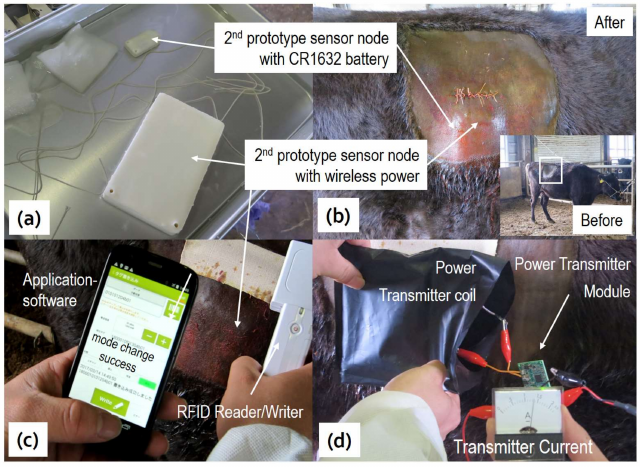
Figure 6. Photos of the sensor nodes ready for implant ( a ); the cow after implant ( b ); remote control test ( c ); and remote wireless charge test ( d